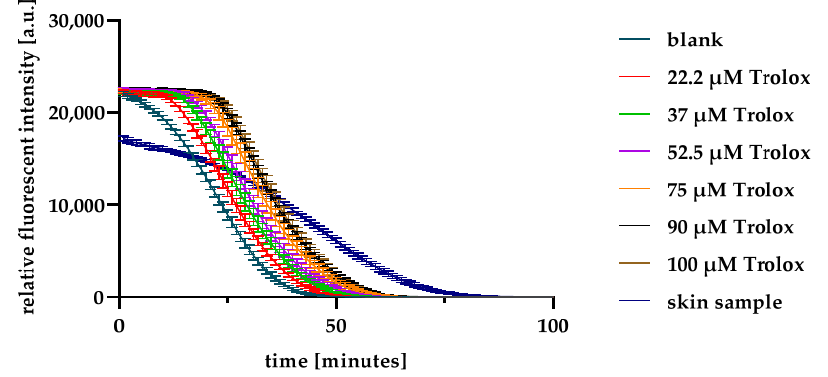
Figure 2. ORAC assay decay curves for Trolox and skin sample.